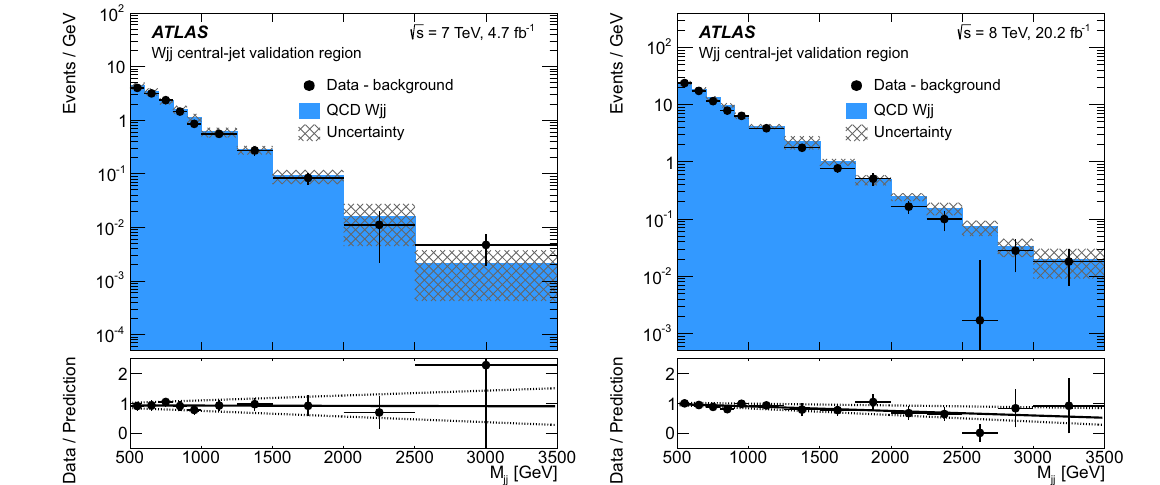
Fig. 8 Comparison of the corrected QCD W jj background dijet mass distribution to data with background processes subtracted, for events in the central-jet validation region in 7 TeV ( left ) and 8 TeV ( right ) data. The bottom panel in each subfigure shows the ratio of data to predic-